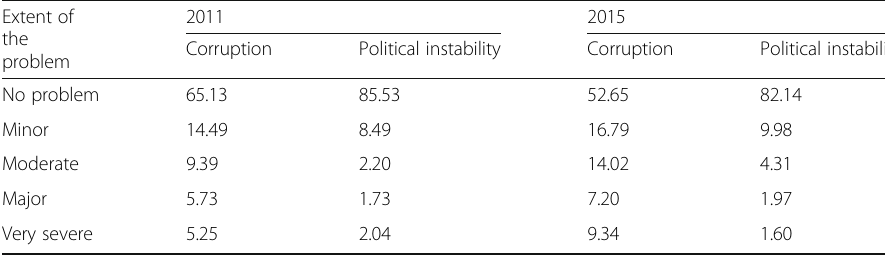
Table 6 Severity of corruption and political instability for enterprises in Ethiopia Extent of 2011 2015 the Corruption Political instability Corruption problem No problem Moderate Very